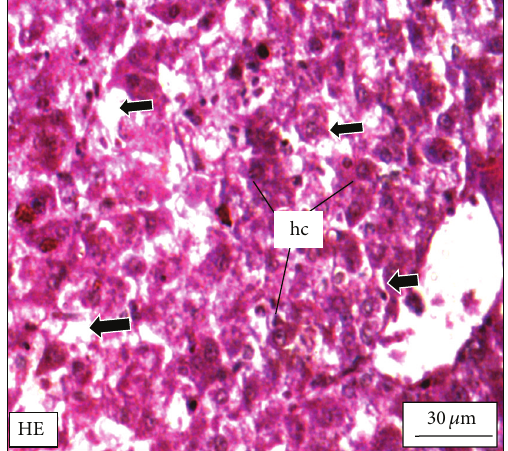
Figure 9: The histological section of the liver of a M. tengara during the late spawning phase (August) depicting the diffused array of hepatocytes (hc) that is diminished in size but bearing prominent nuclei. The fat vacuoles are totally absent; instead some conspicuous empty spaces (black solid arrows) are generated in between the hepatocytes when the tissues are treated with ZnS nanoparticles at the concentration of 500 𝜇 g/L [HE: Haematoxylin-Eosin stain].